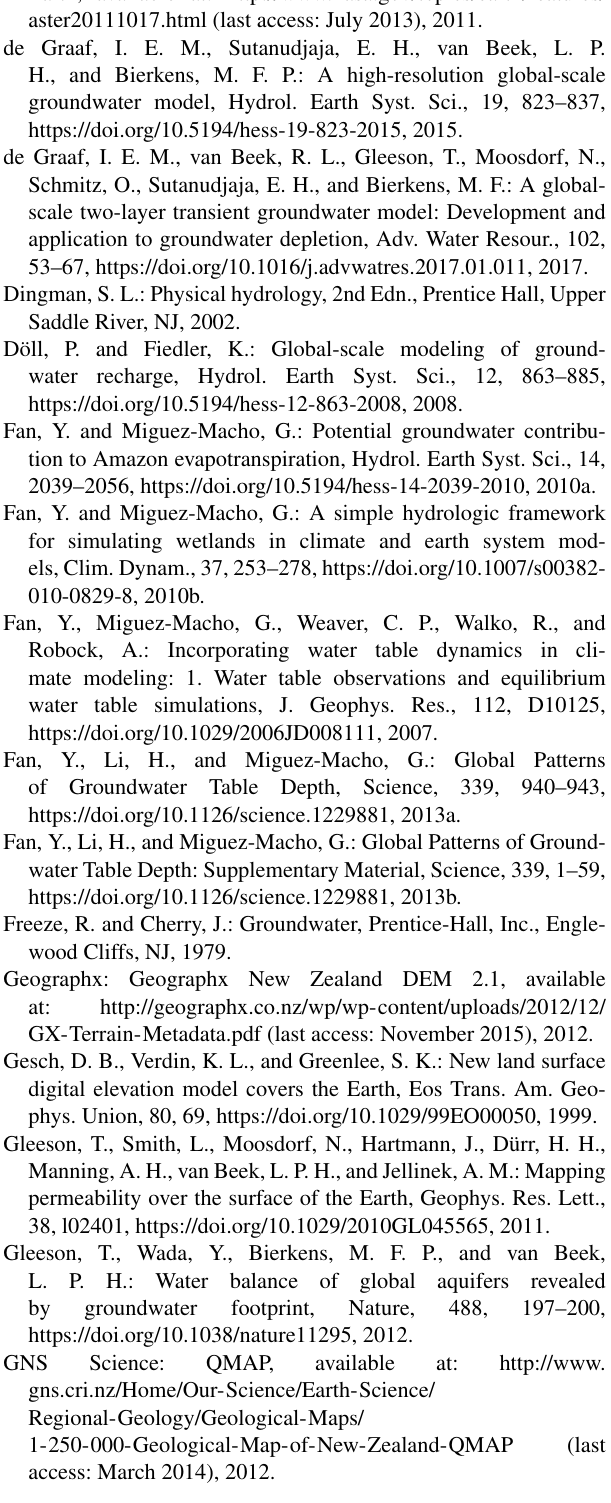
water Table Depth: Supplementary Material, Science, 339,